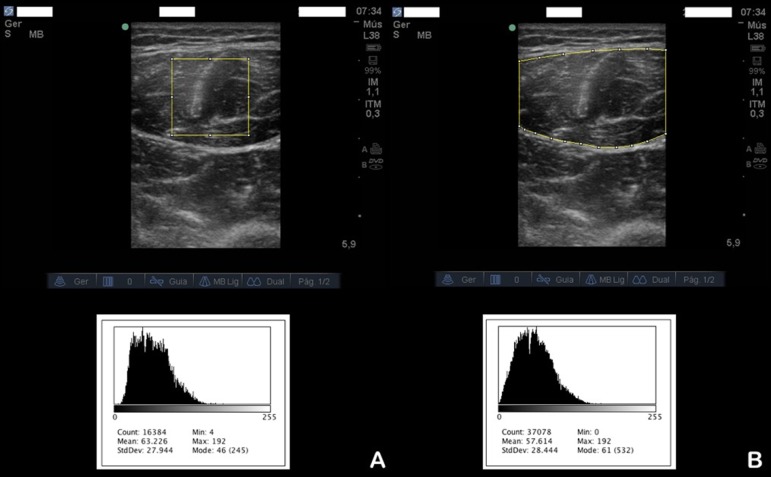
Example of image processing to measure muscle echogenicity. The selected area represents the region of interest, using (A) the square method or (B) the trace method; the grayscale is defined by the histogram below each image.